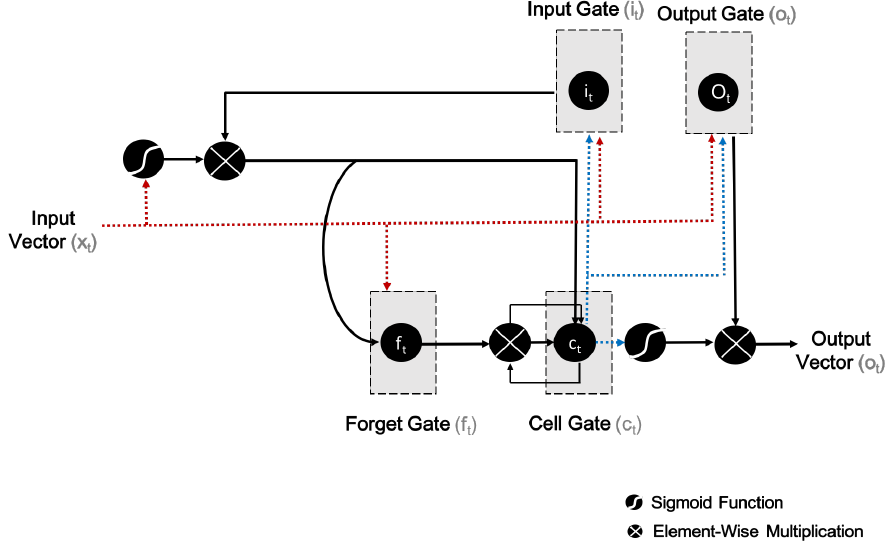
Figure 3. Architecture of a long short-term memory (LSTM) unit.